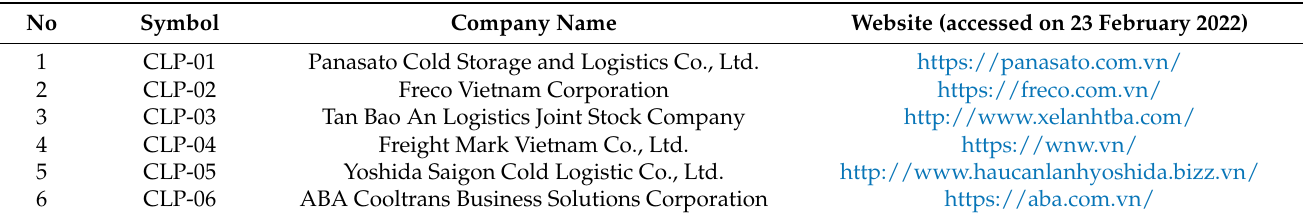
Table 4. The list of cold chain logistics service providers used in this study.